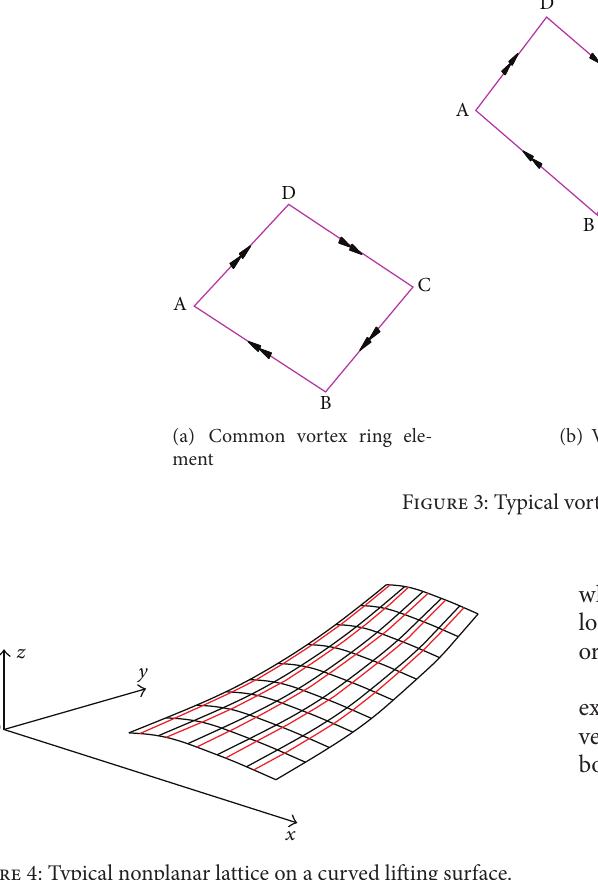
Figure 4: Typical nonplanar lattice on a curved lifting surface.